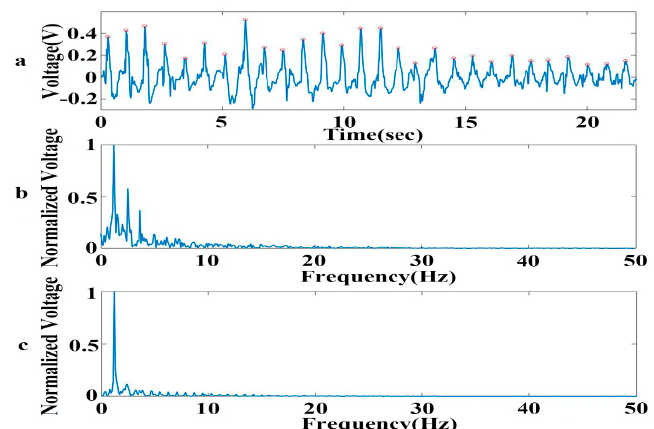
Figure 7. Signal acquired by graphene sensor for measuring pulse wave. ( a ) Voltage signal obtained by graphene sensor. ( b ) Spectral analysis of the pulse signal by the graphene sensor. ( c ) Spectral analysis of the pulse signal measured by a traditional sensor.